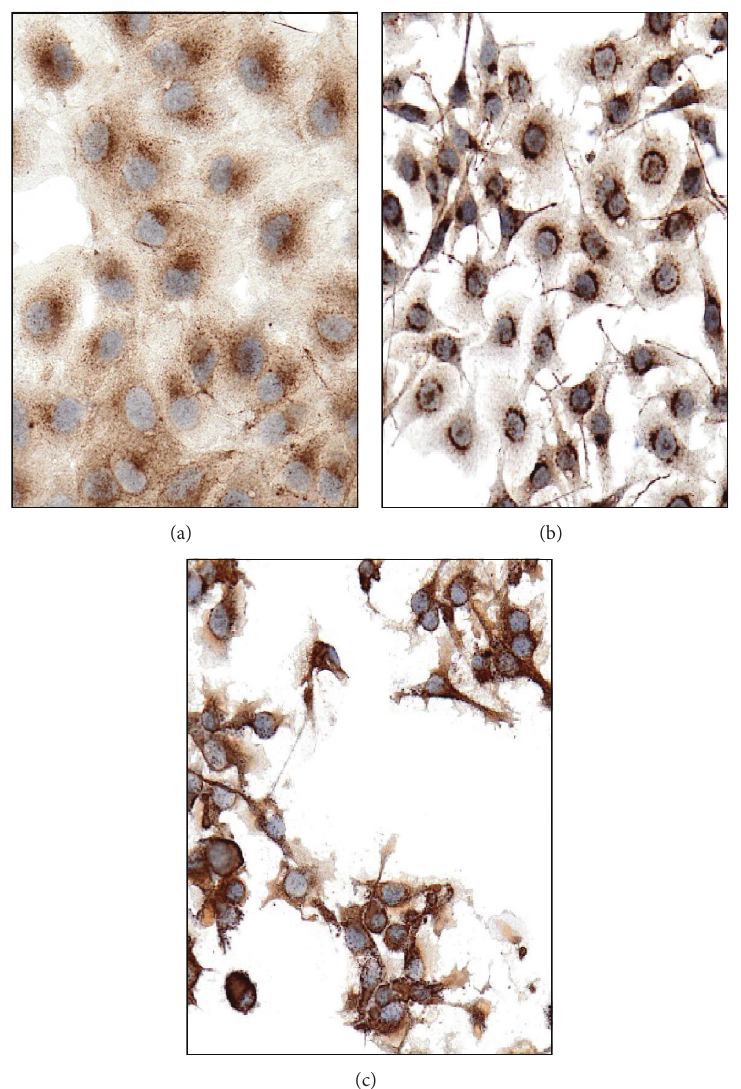
Figure 3: TfR1/CD71 is differentially expressed in thyroid tumor cell lines: increasing cytoplasmic expression is seen in neoplastic cells from PTC (a), FTC (b), and ATC (c).